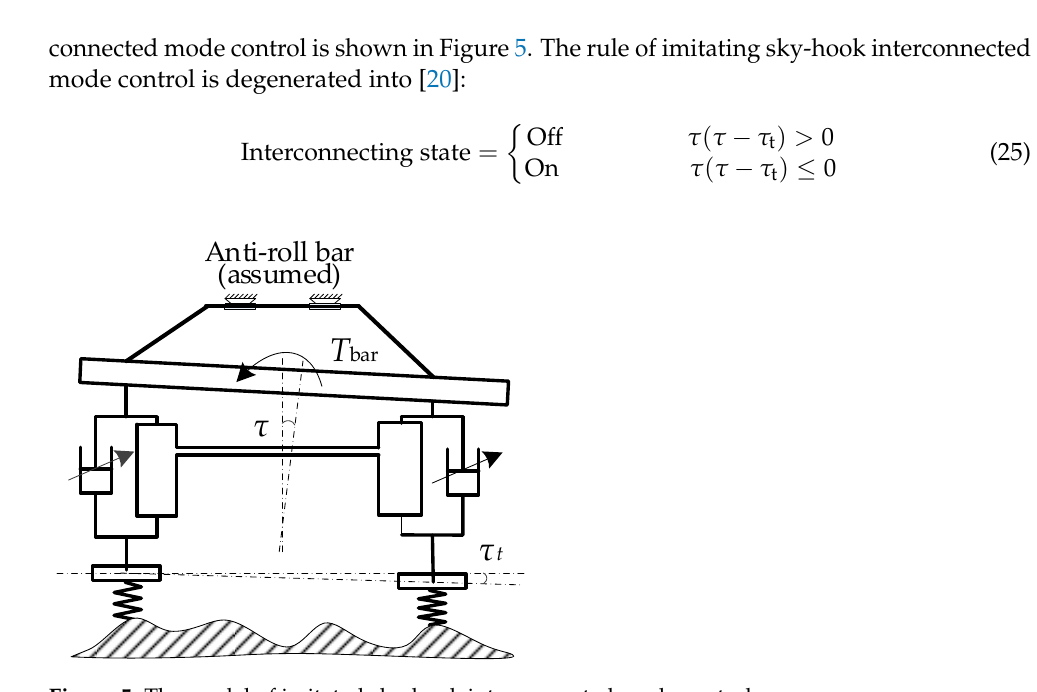
In the current sampling time of vehicle state, the suspension forces generated by the